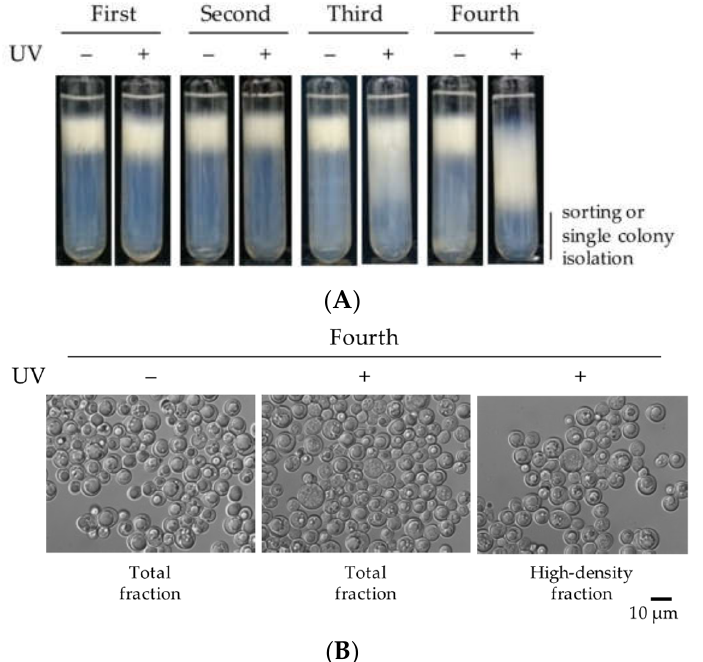
Figure 1. Isolation of the mutant strain sr22 in the screening. ( A ) Enrichment of high-density cells by Percoll density gradient centrifugation four times after UV irradiation (+) or not ( − ). The cells cultured for six days on S medium were separated by Percoll density gradient centrifugation (90%). The bottoms (3 mL) of the sample fractions after the centrifugation were subjected to sorting or single colony isolation. ( B ) Differential interference contrast (DIC) microscopy images of UV-untreated cells in the total fraction and UV-treated cells in the total and high-density fractions.